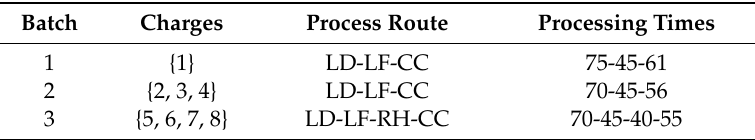
Table 2. Characteristics of the given charges.